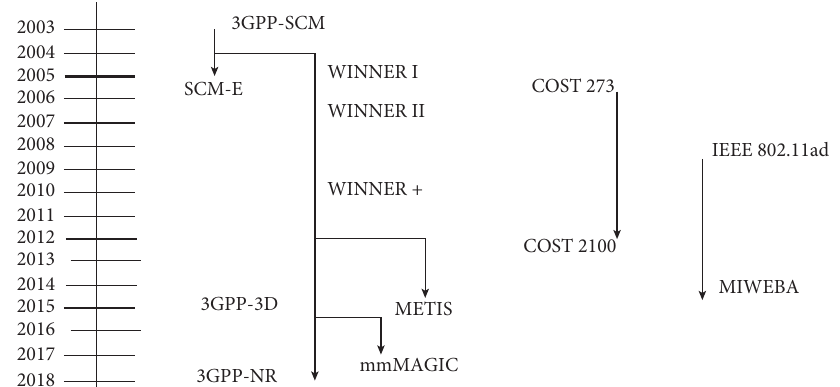
Figure 1: Standard channel models and their family history.